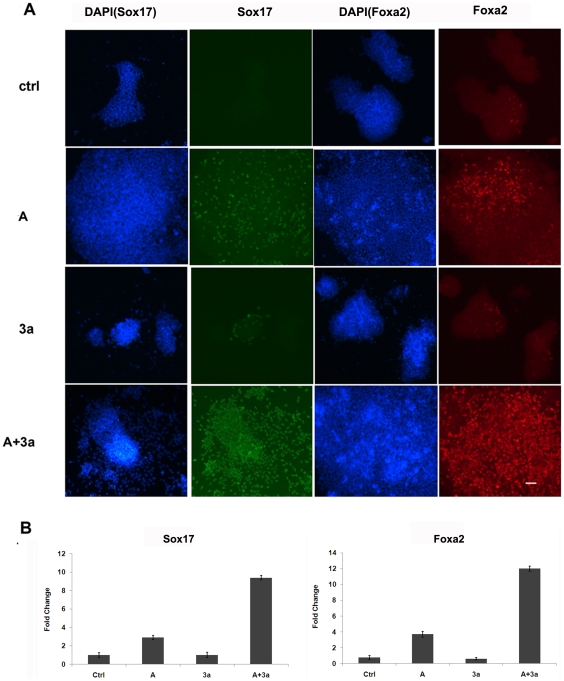
Wnt3a improves the efficiency of Activin A induced DE differentiation from mouse ESCs.The mouse ESC line, TCL-1 cells, were treated with 100 ng/ml Activin A, 50 ng/ml Wnt3a, or 100 ng/ml Activin A plus 50 ng/ml Wnt3a, respectively. The differentiated cell samples were collected 5 days after treatment for DE marker analyses by using IF and RT-qPCR. A. IF staining of Sox17 and Foxa2 expression in differentiated mouse ESCs treated with different growth factors. Scale bar: 50 uM. B. RT-qPCR examination of the expression of DE markers, Sox17 and Foxa2. Data are expressed as mean fold change ± SD. A: Activin A; 3a:Wnt3a.